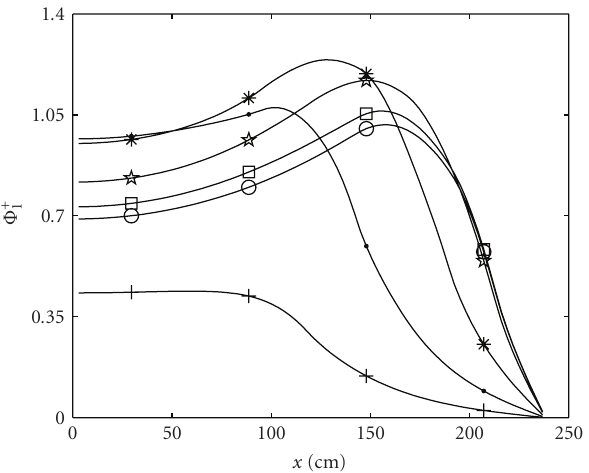
Figure 7: Graphs of the neutron importance for the first group.